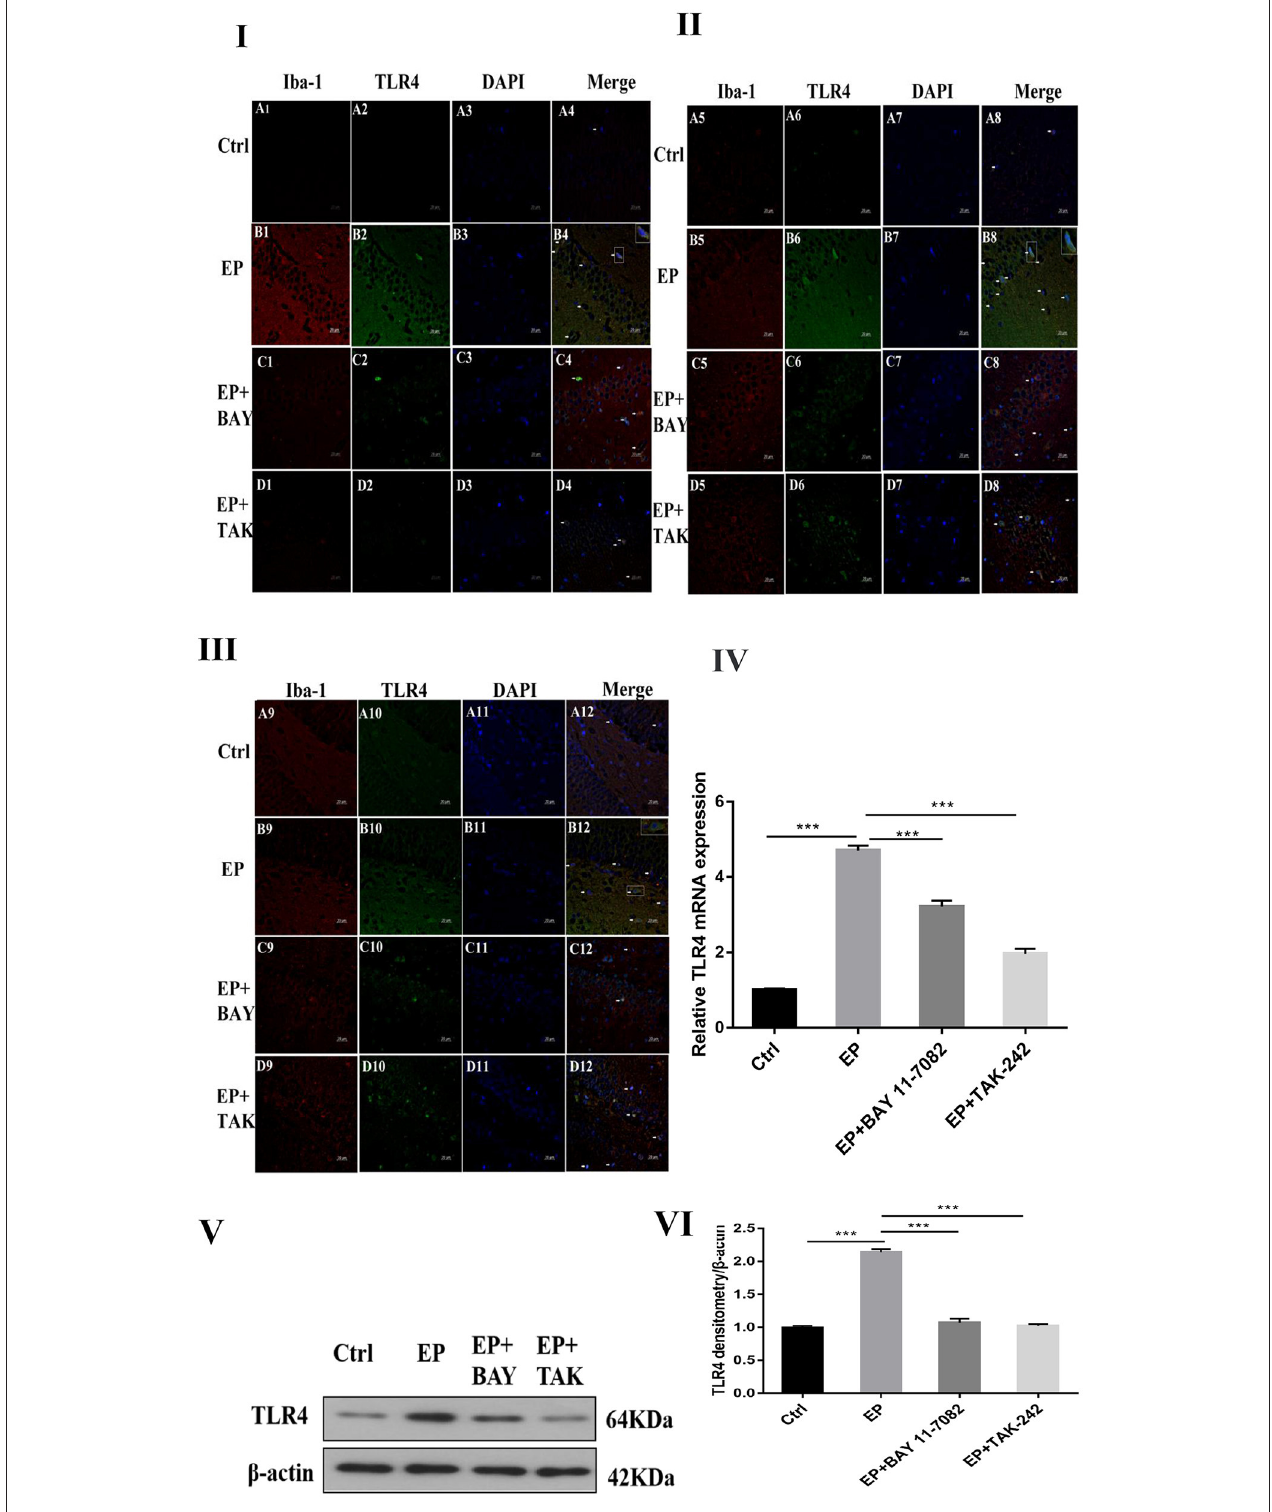
FIGURE 2 | TLR4 expression in rats in each group after I downregulated the TLR4/NF- κ B inflammatory pathway. * P < 0.05; ** P < 0.01; *** P < 0.001.